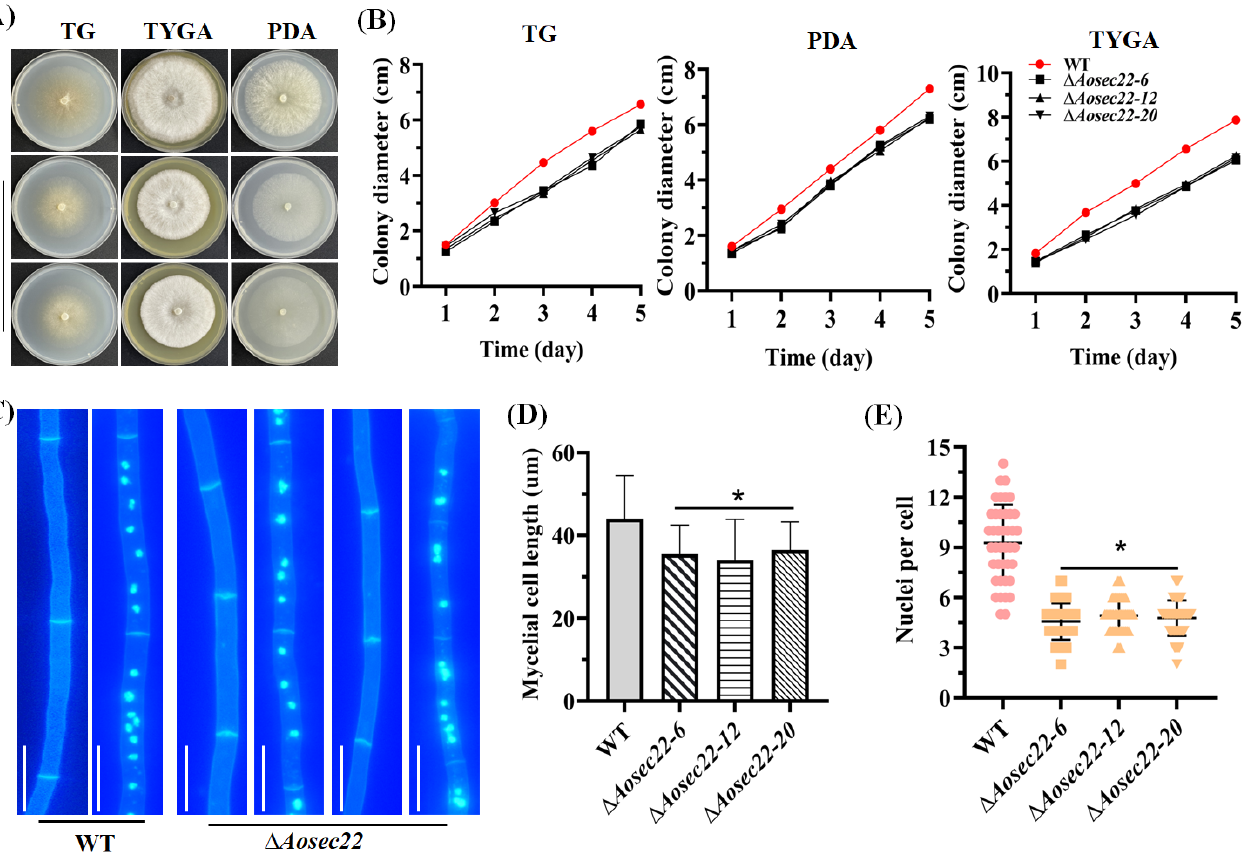
Figure 1. Comparison of mycelial growth of wild-type (WT) and mutant strains in A. oligospora . ( A ) Colony morphology of fungal strains incubated for 5 days on PDA, TG, and TYGA plates at 28 °C. ( B ) Diameters of fungal colonies in ( A ). ( C ) Hyphae of the WT and mutant strains stained with calcofluor white (CFW) and 4′,6 -diamidino-2-phenylindole (DAPI) after 7-day incubation on CMY. One hundred hyphal cells were randomly selected for the counts of nuclei. Bar: 10 μm. ( D , E ) Length of hyphal cells and count of nuclei in ( C ). Measurements represent the average of three independent experiments. The asterisk indicates a significant difference between the mutant and WT strains ( p < 0.05).